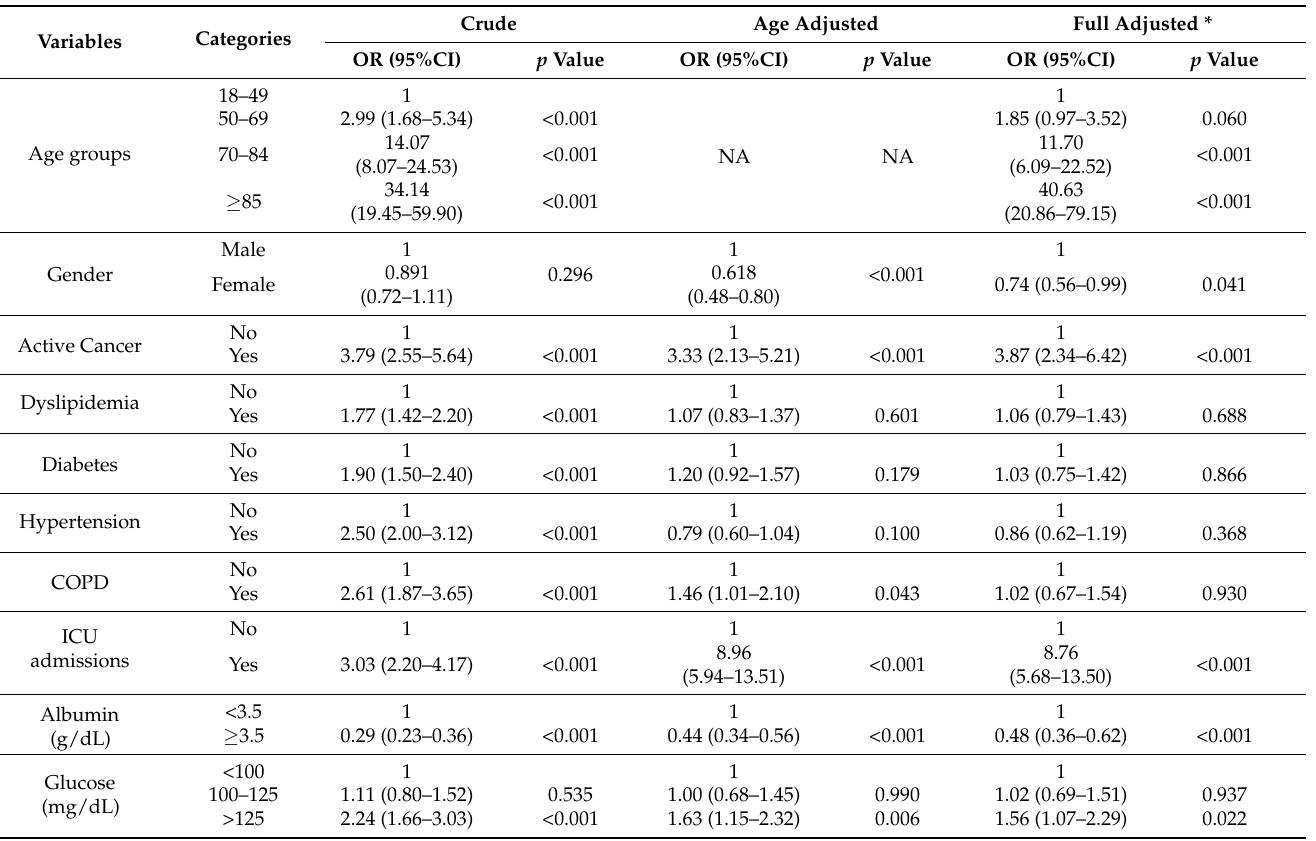
* Adjusted by all variables included in the table. Abbreviations—COPD: chronic obstructive pulmonary disease. ICU: intensive care unit. NA: not applicable. The value of the Hosmer–Lemenshow goodness-of-fit statistic was 12.59 and 0.127 the corresponding p -value. This indicates that the proposed model seems to fit quite well.